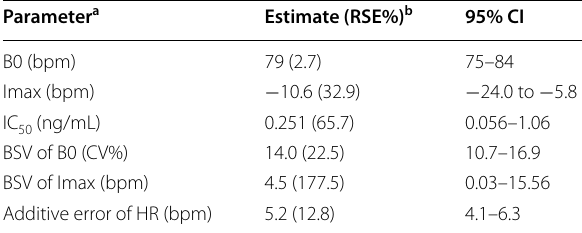
Table 4 Parameter estimates of the HR Imax model